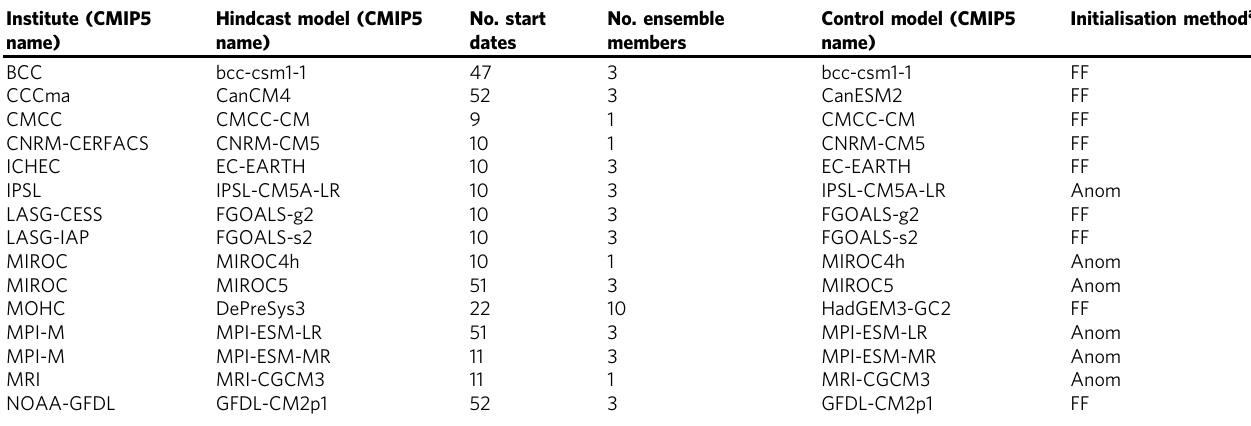
Table 1 The decadal prediction hindcast systems and preindustrial control simulations used in this analysis using the